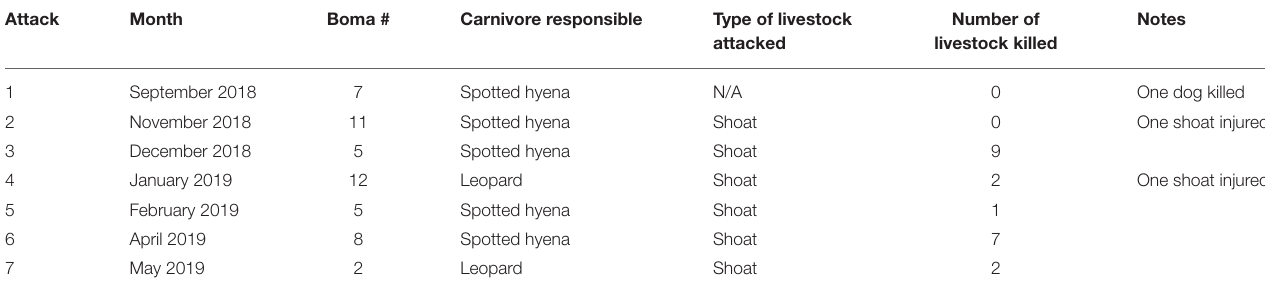
TABLE 2 | The seven carnivore attacks on livestock reported at 12 bomas in Central Kenya from September, 2018 to May, 2019. Attack